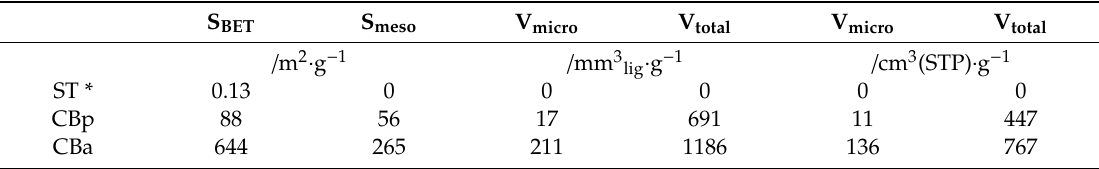
Table 1. Textural properties of original scrap tyre and produced carbon blacks.